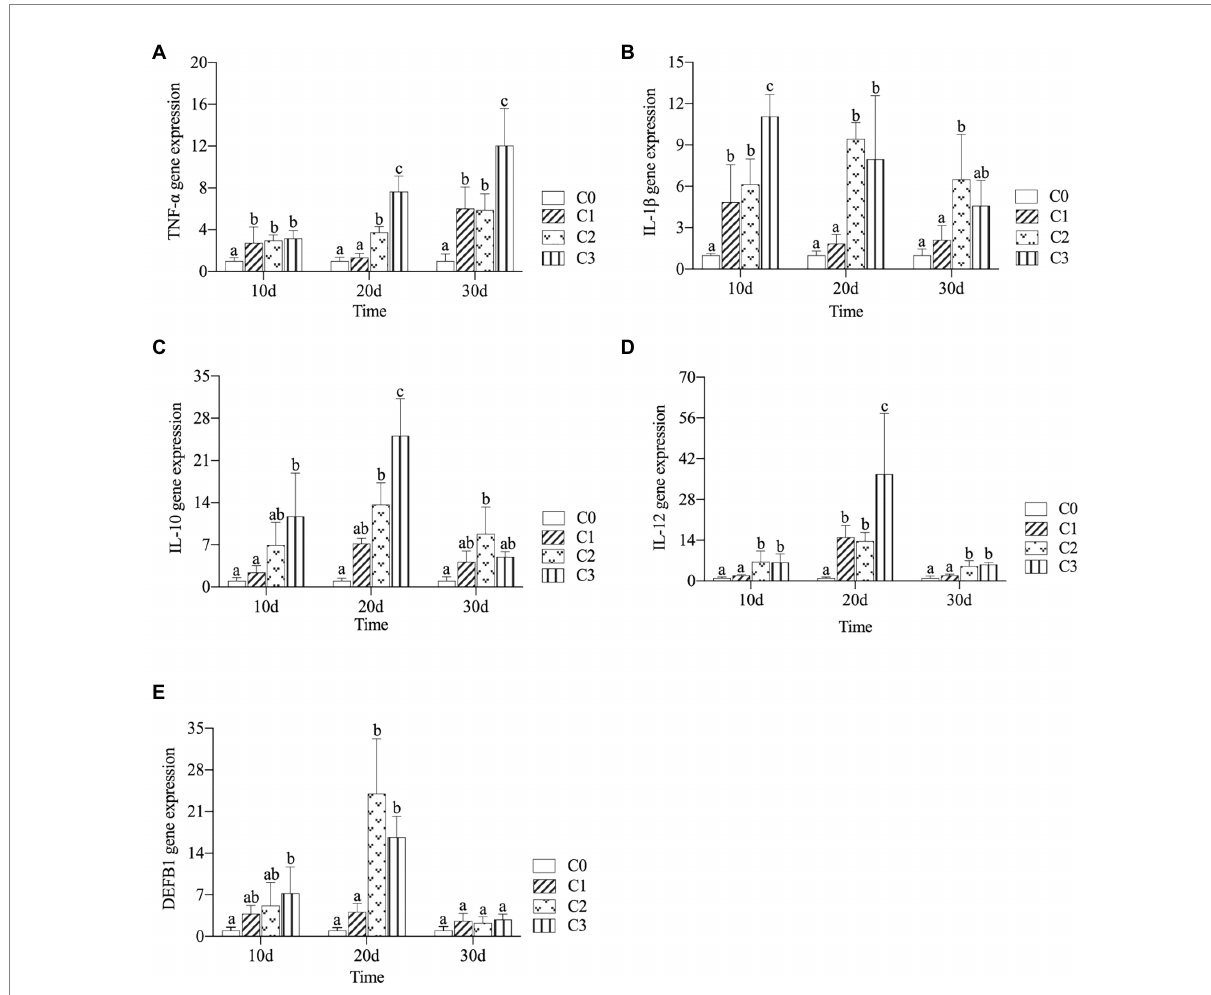
FIGURE 4 Effects of AVH-AgNPs on the gene expression levels of TNF- α (A) , IL-1 β (B) , IL-10 (C) , IL-12 (D) , and DEFB1 (E) . C0, C1, C2, and C3 refer to 0, 6, 9, and 18 μ g/l of AVH-AgNPs, respectively. Values are expressed as mean ± SE ( n = 3). Bars with different letters indicate significant differences ( p <